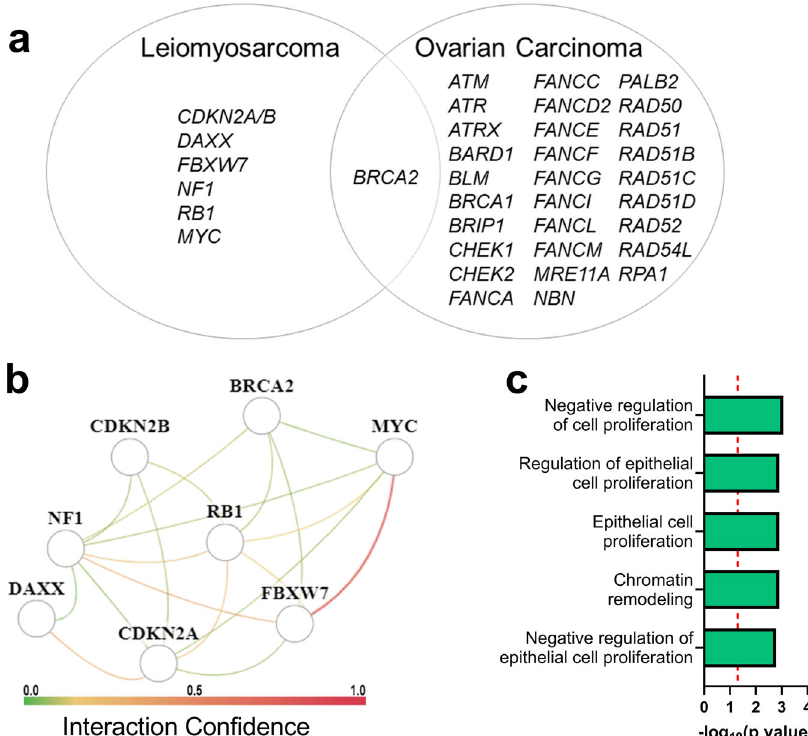
Fig. 4 Elevated gLOH is a Positive Prognostic Indicator in Non-metastatic LMS. To assess the prognostic value of gLOH in LMS, we analyzed a sub-cohort of 40 patients with early stage LMS treated at the Ohio State University Comprehensive Cancer Center, whose tumors were sequenced by Foundation Medicine. In total, 40T > 1 LMS non-metastatic at diagnosis were collected. All subjects were treated initially with total resections. a While too few genomic alterations were present in the other LOH in LMS gene signature genes to conduct survival analysis, subjects whose tumors harbored homozygous deletion of BRCA2 or ampli fi cation of MYC survived through the end of data collection. b gLOH scores above the group median (9.9%) were associated with an improved prognosis (HR 0.31, 95%CI 0.11 – 0.94, p = 0.02). c In uLMS, elevated gLOH was highly correlated with improved survival (HR 0.20 95%CI 0.05 – 0.85, p = 0.02). This effect was not identi fi ed in non-uLMS (HR 0.47 95%CI 0.08 – 2.6 p =